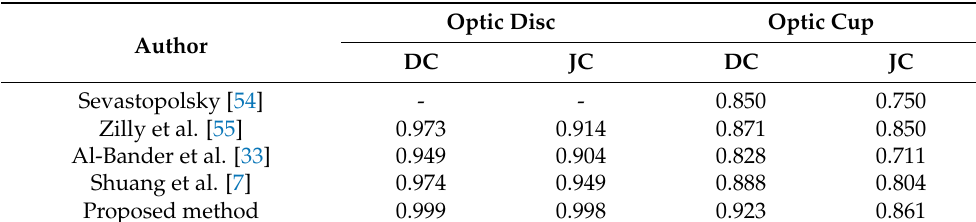
Table 4. Comparison of segmentation methods for optic cup and disc. The model was finetuned on